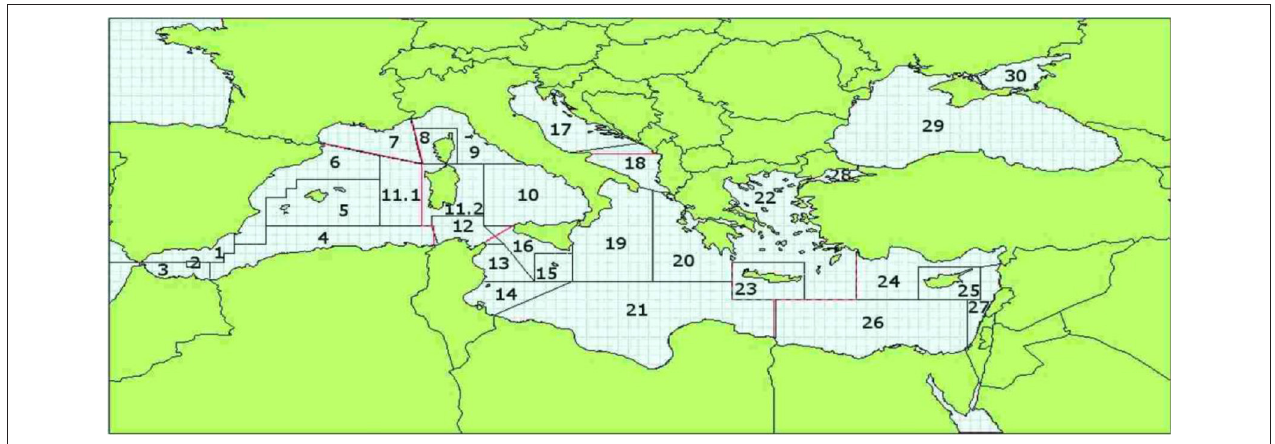
FIGURE 1 | Map of the GFCM Geographical Sub-Areas (GSAs) established in the resolution GFCM/33/2009/2 (GFCM, 2009d).